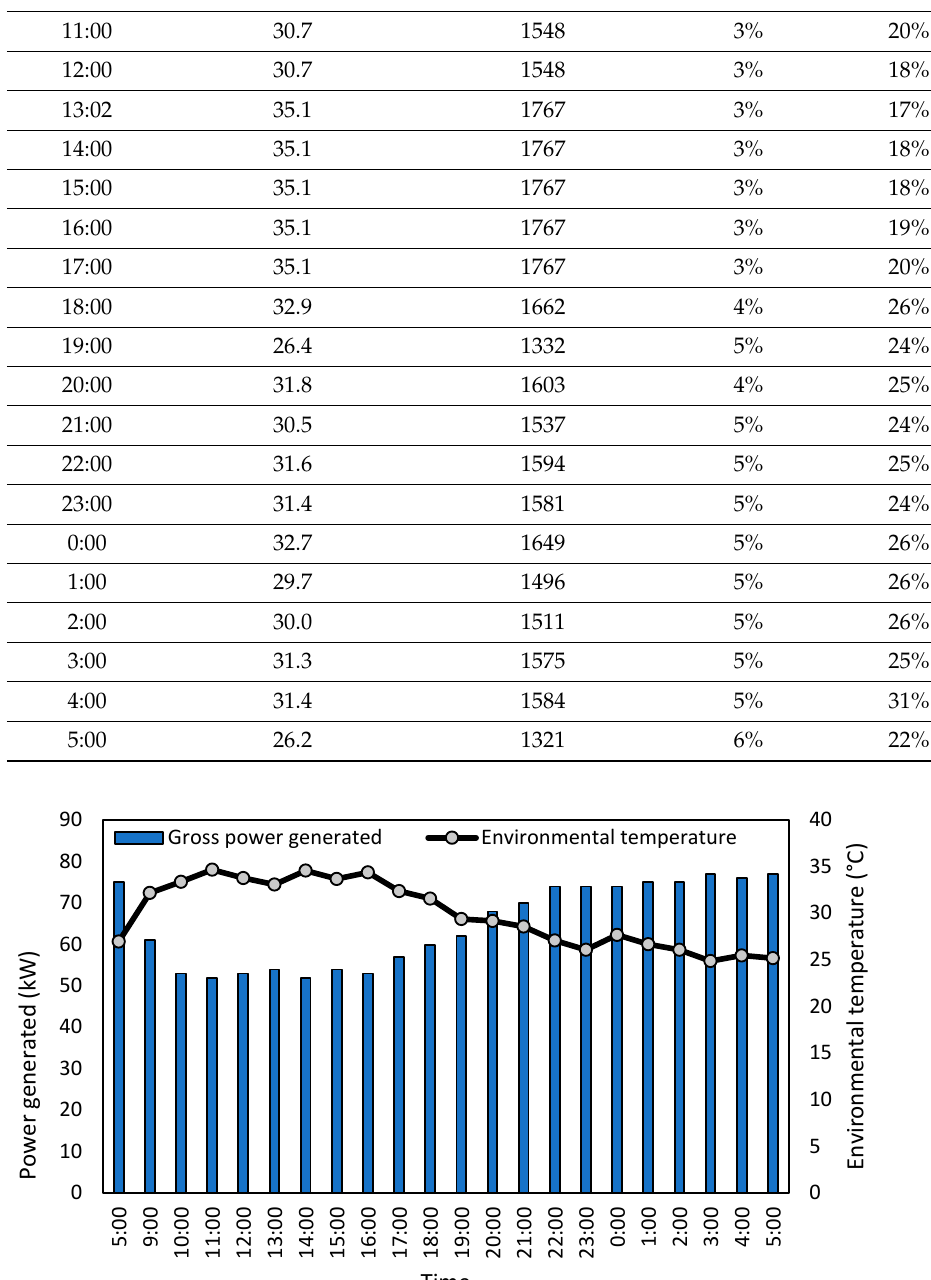
Table 3. Monitoring parameters of the energy production in the ORC system.